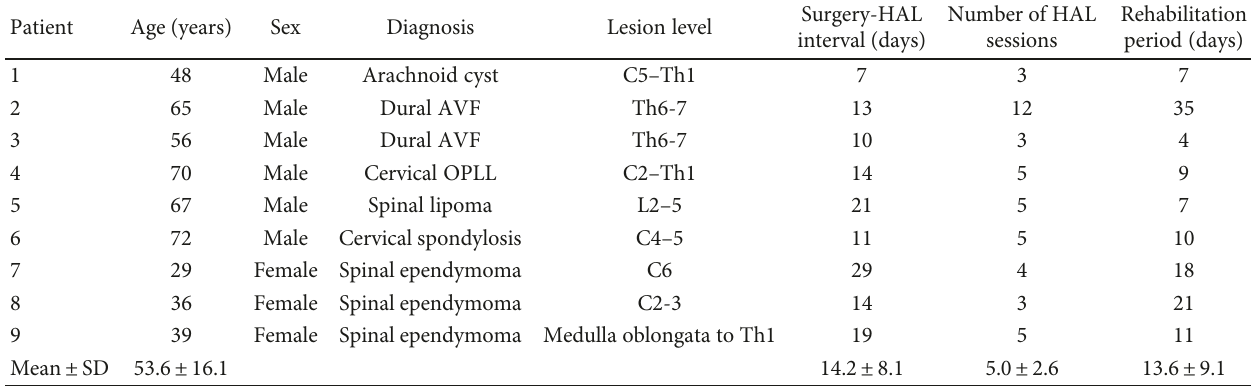
Table 1: Patient characteristics.